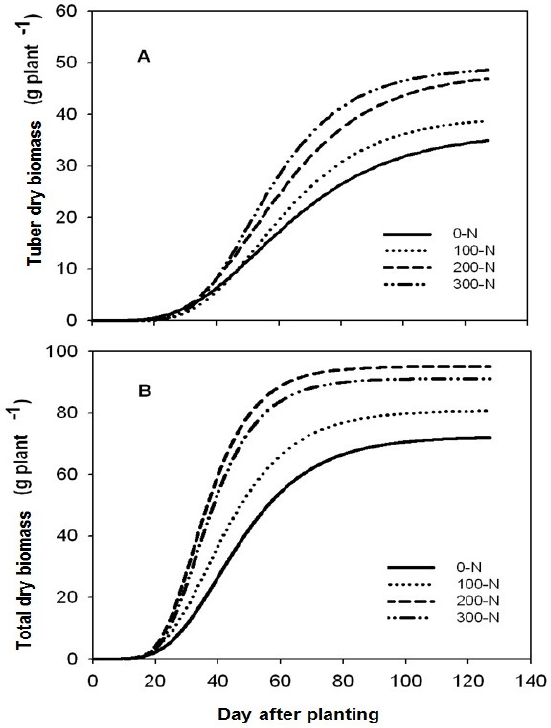
Figure 2. Pattern of total dry biomass accumulation in tubers (A) and total dry biomass (B) during days after planting (DAP) in the different treatments of nitrogen fertilization: 0, 100, 200 and 300 kg N ha -1 . The curves correspond to the adjustments Gompertz